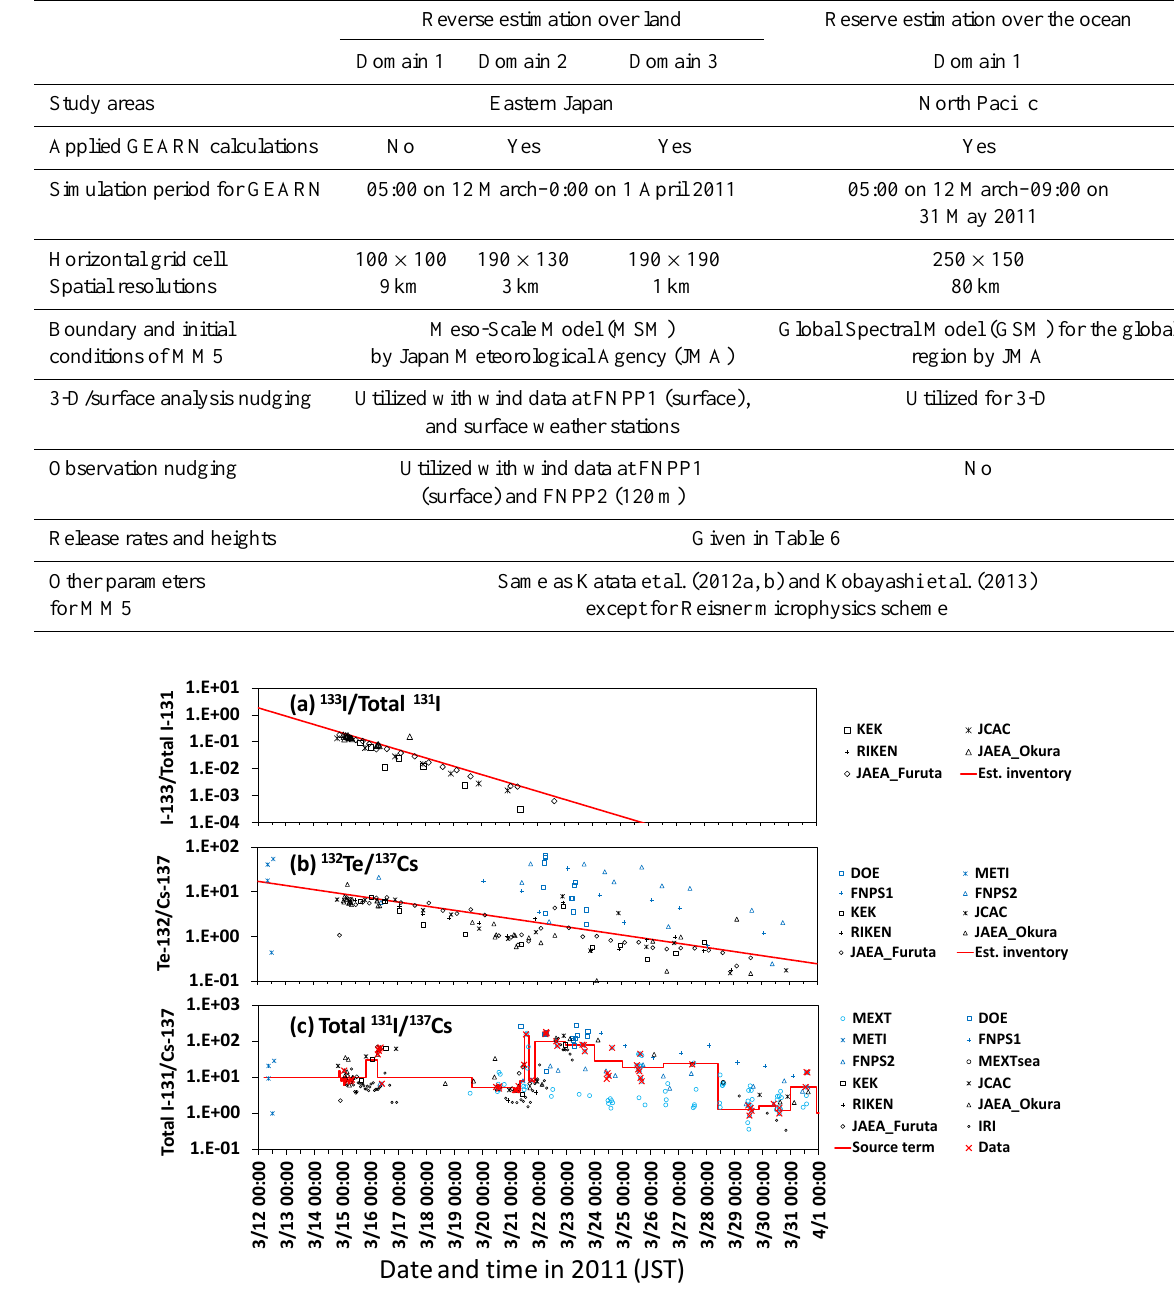
Figure 4. The time series in (a) the ratios of 133 I to total 131 I, (b) 132 Te to 137 Cs, and (c) total 131 I to 137 Cs in the atmosphere for the data sampled at each station [blue symbols: METI, FNPS1, FNPS2, MEXT, MEXTsea, and DOE] and at off-site monitoring sites in eastern Japan (black symbols: JAEA-Tokai, KEK, RIKEN, JCAC, and Tokyo Metropolitan Government (IRI)) from 12 to 31 March 2011. The red solid lines in (a) and (b) are the curves derived from the inventories and radioactive decay with the value of 132 Te/ 137 Cs = 20 at the shutdown time. The red solid line in (c) represents the ratio of total 131 I to 137 Cs for the source term estimated in this study, which is assumed or determined from the data shown as the red symbols in (c)